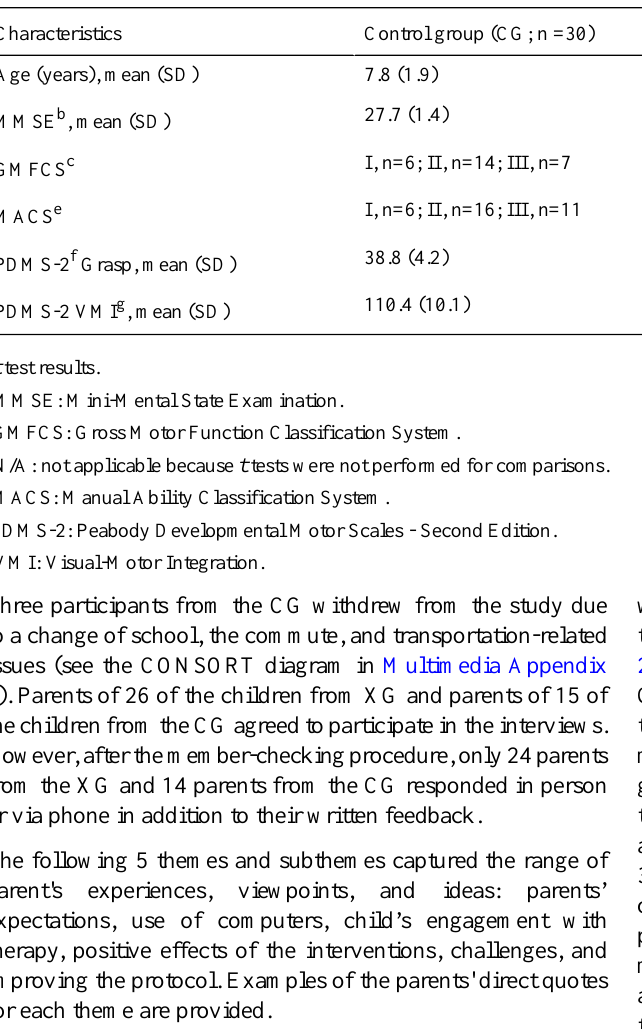
Table 1. Demographic and clinical characteristics of the